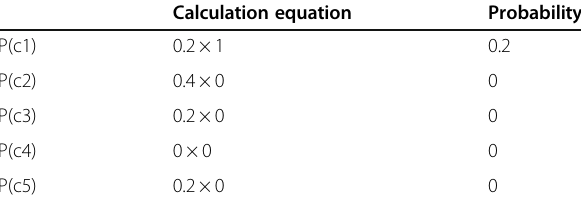
Table 1 The calculation of first point probability